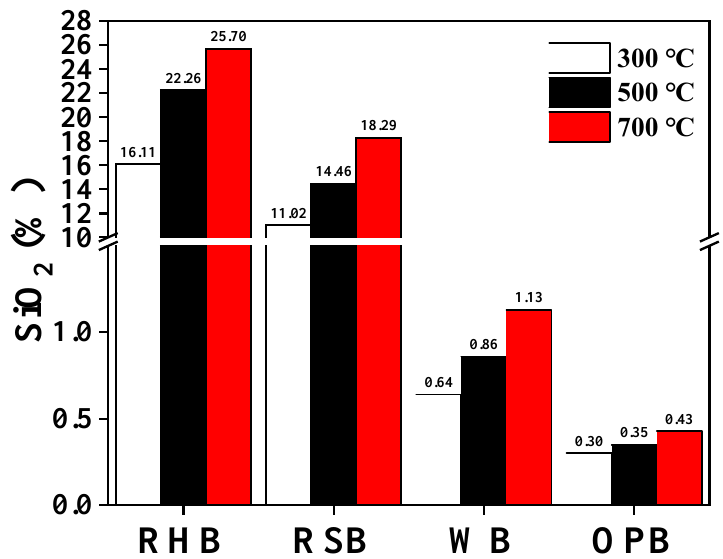
Figure 3. Silica contents of rice husk biochar and other biochar [152,159,160].